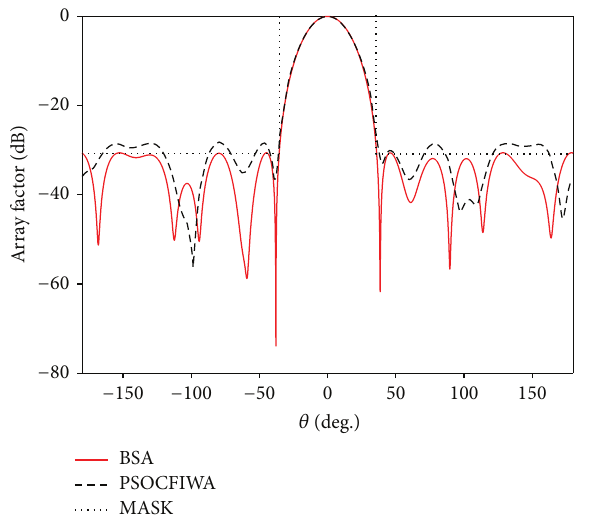
Figure 7: The radiation patterns obtained by BSA and RGA [2] for CCAA without central element.